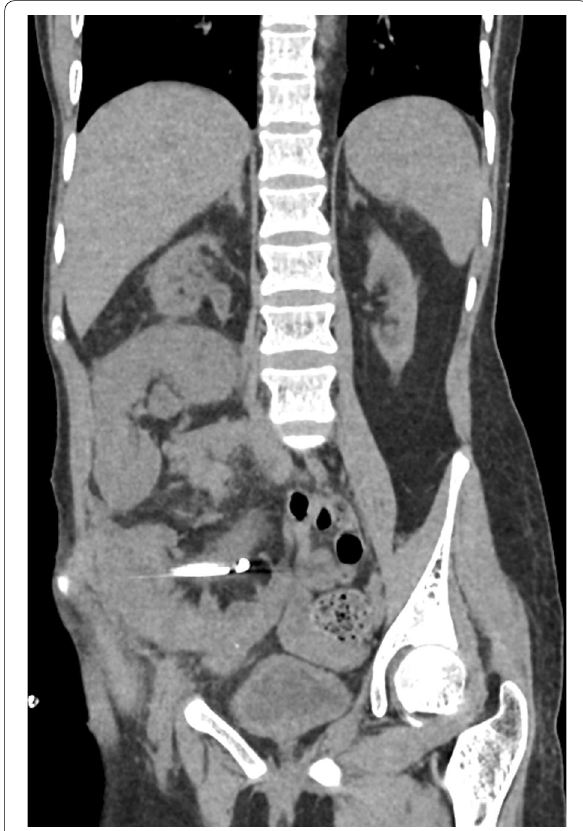
Fig. 4 Postoperative CT scan without neither residual fragments nor subcapsular